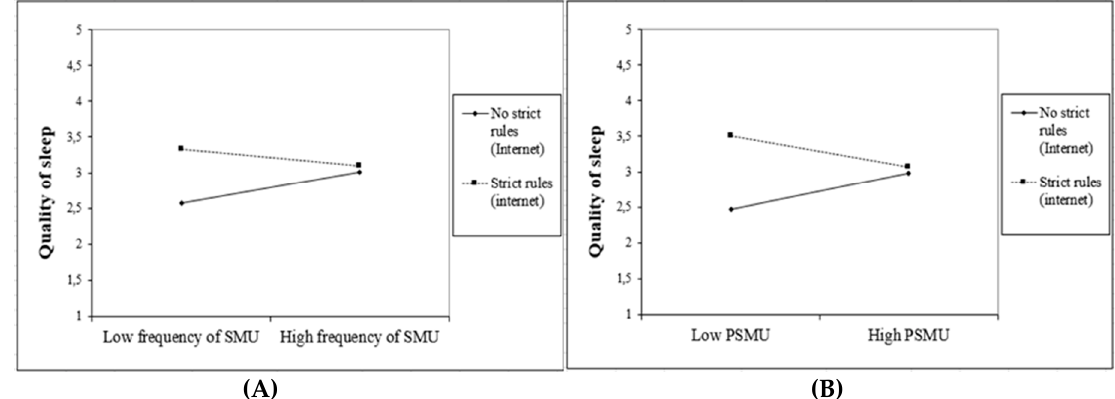
Figure 1. Moderation of the Effect of the Frequency of Social Media Use (SMU; 1A) and Problematic Social Media Use (PSMU; 1B) on Perceived Quality of Sleep by Parental Rules about using the Internet in the Hour before Going to Sleep.